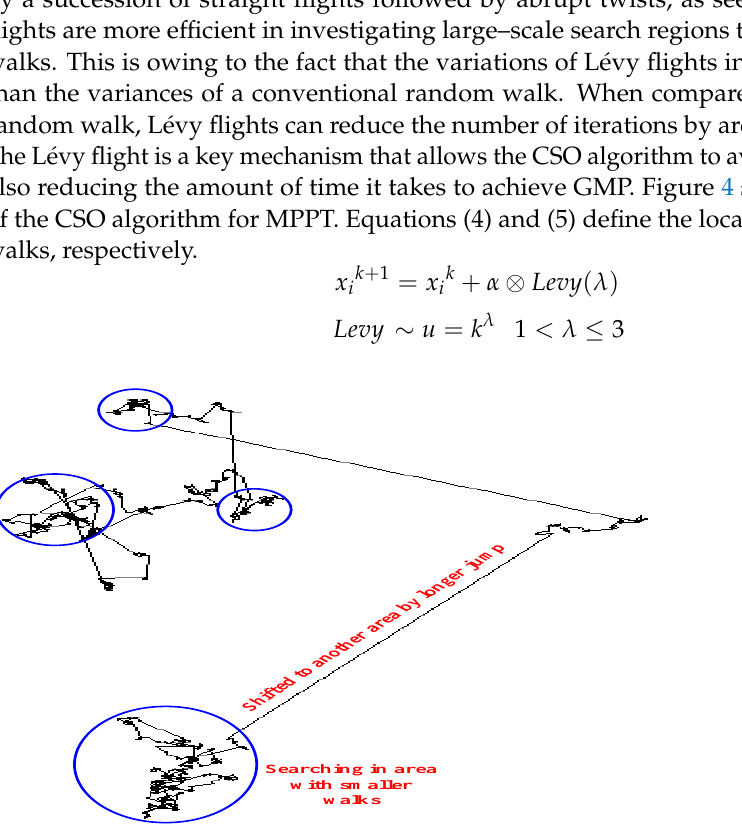
Figure 3. Example of Lévy flight. The symbol ⊗ indicates that the multiplications are done entry by entry. The successive walks of the cuckoo effectively comprise a random walk process that follows a power-law step-length distribution with a heavy tail.